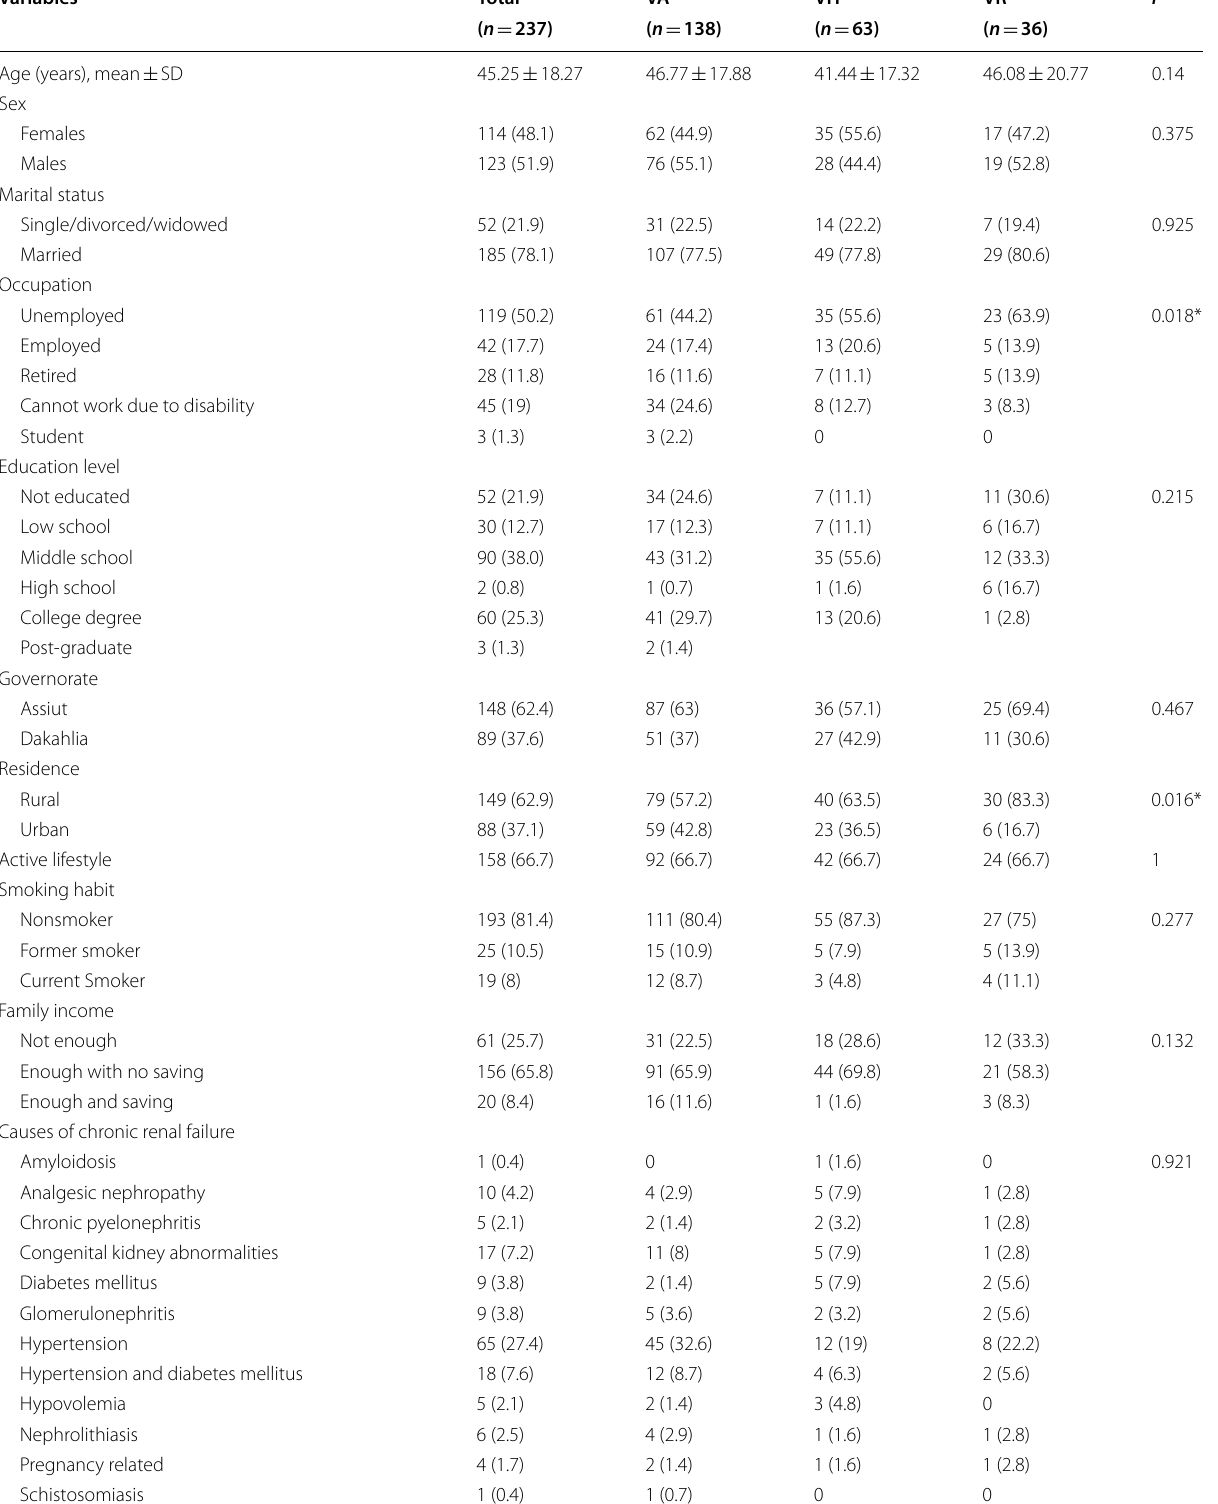
Table 1 Demographic and clinical data of hemodialysis patients according to intention to get the COVID-19 vaccine